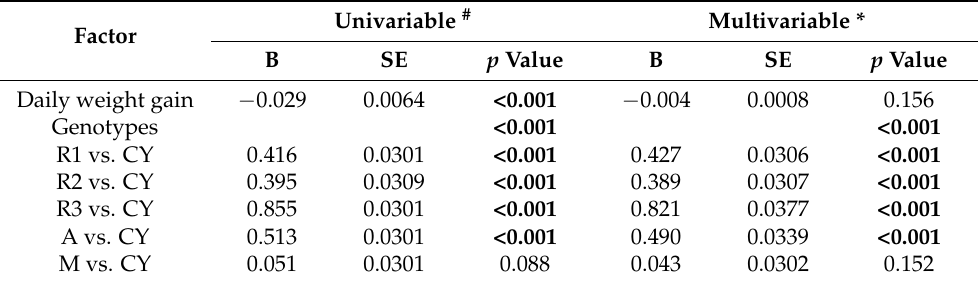
Table 5. Factors affecting the adaptability score: results of uni- and multivariable analyses. Factor